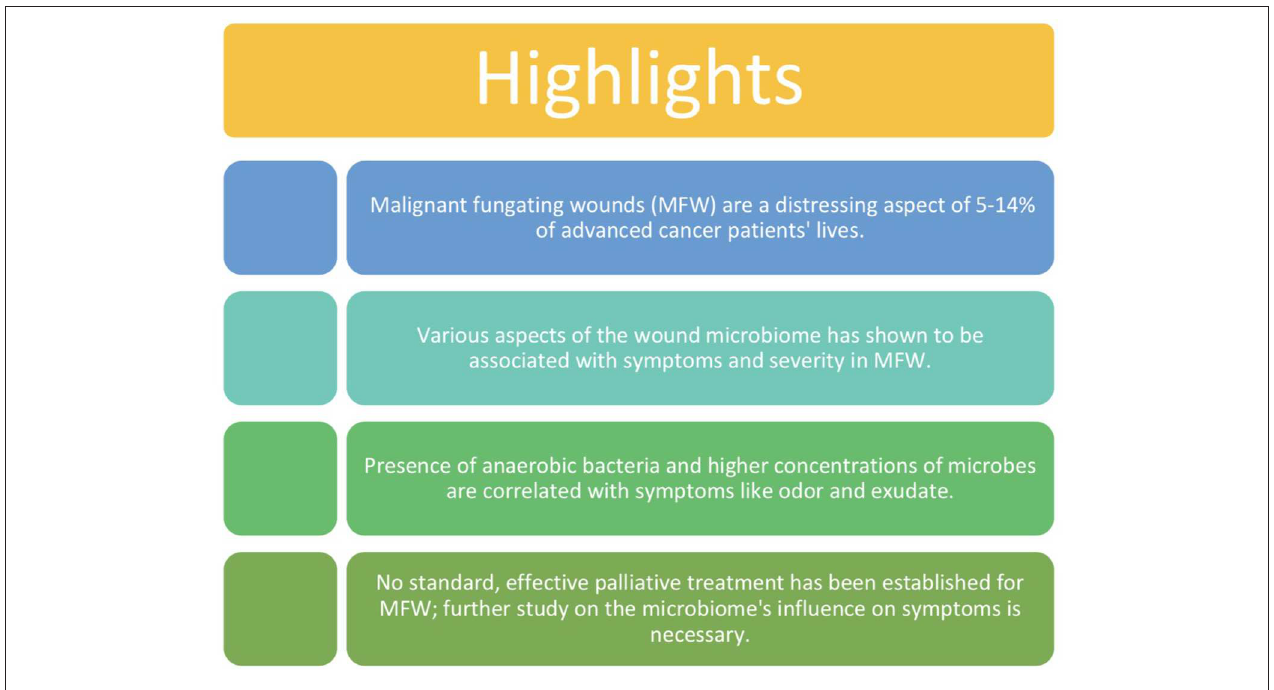
FIGURE 2 | Key points of this literature